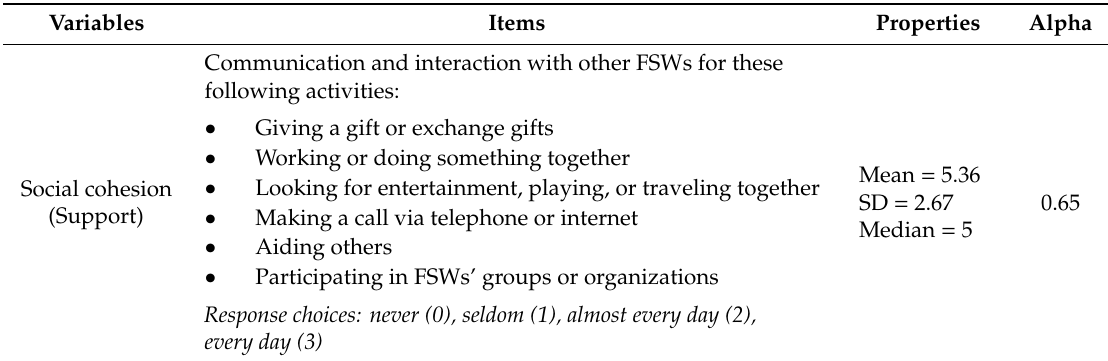
Table 1. The measurement of social capital